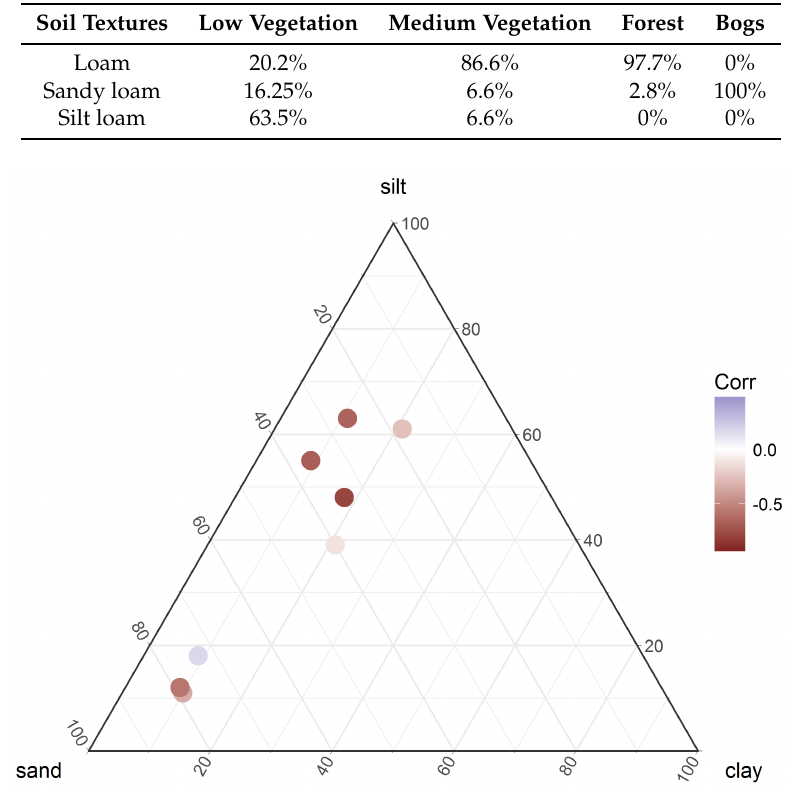
Table 5. Percentage of boreholes (with ground temperature sensors in the upper 20 cm) of different soil textures (loam, sandy loam and silt loam) for different landscape types (low vegetation, medium vegetation, forest, and bogs).